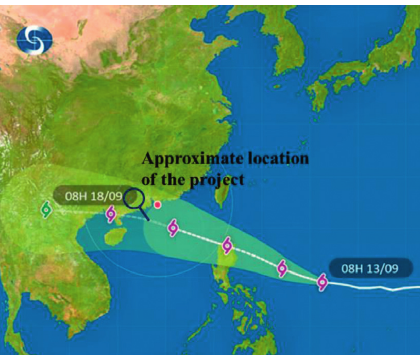
Figure 8: Typhoon “Mangosteen” path and meteorological